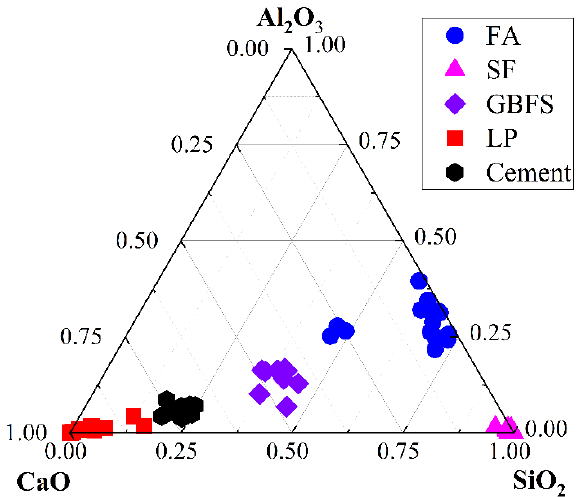
Figure 2. Chemical composition of FA [8,13–25], SF [9,26–41], GBFS [42–54], LP [55–63], and cement [19–28,38–40,64–66].